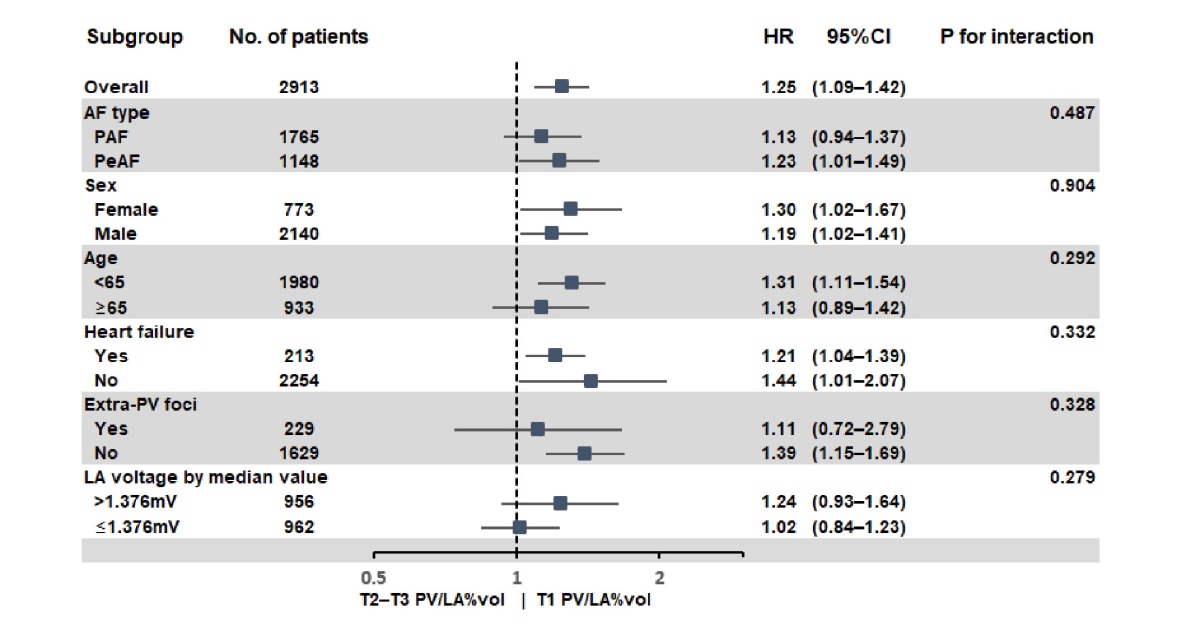
FIGURE3 Subgroup analysis of AF recurrence after AFCA according to PV/LA%vol. AF, atrial fibrillation; AFCA, atrial fibrillation catheter ablation; LA, left atrium or left atrial; PV, pulmonary vein; PV/LA%vol, pulmonary vein to left atrium volume percent